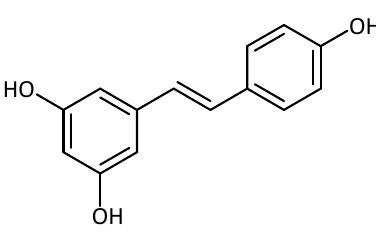
Figure 12. Structure of resveratrol.